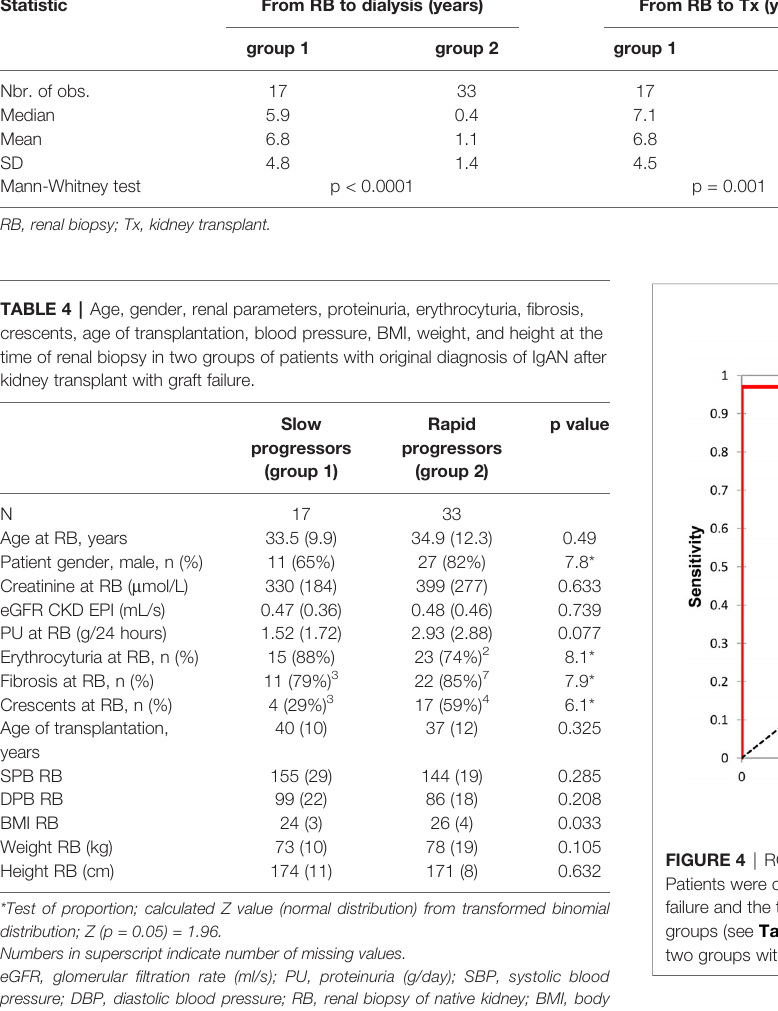
TABLE 3 | Two groups of patients with original diagnosis of IgAN after kidney transplant and graft failure were differentiated by agglomerative hierarchical clustering. Statistical parameters Statistic From RB to dialysis (years)